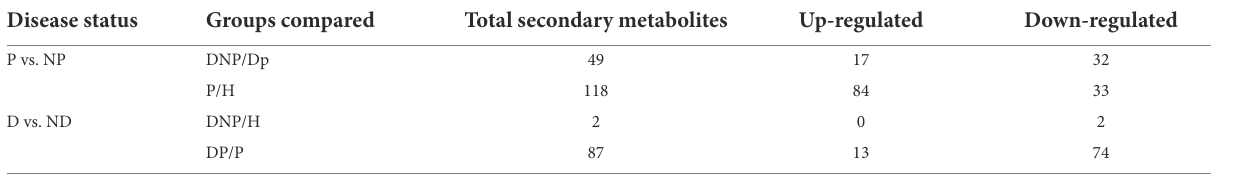
TABLE 3 Distribution of secondary metabolites.